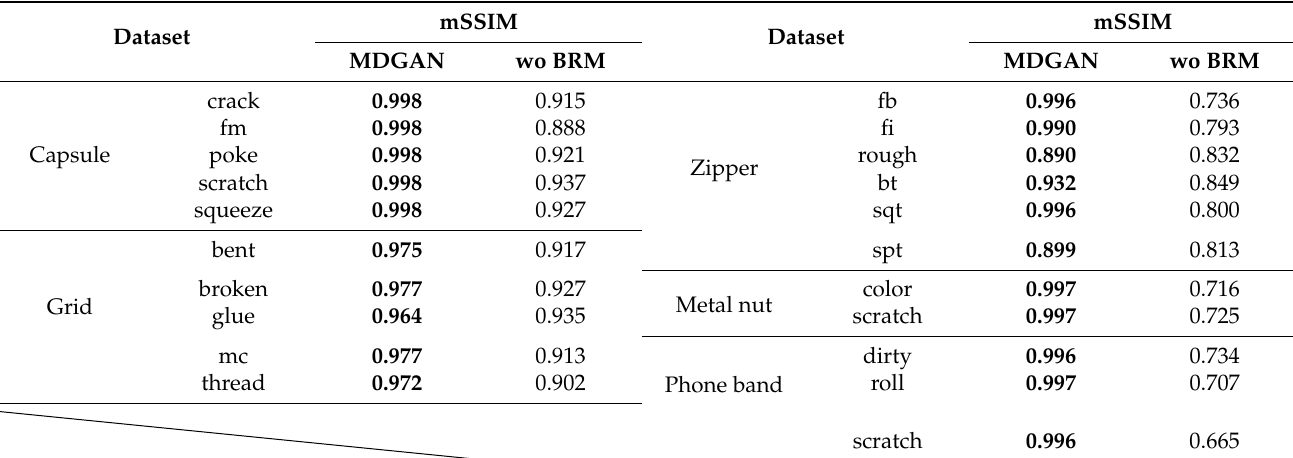
Table 2. Quantitative results of the ablation experiments. Bold fonts indicate better results.